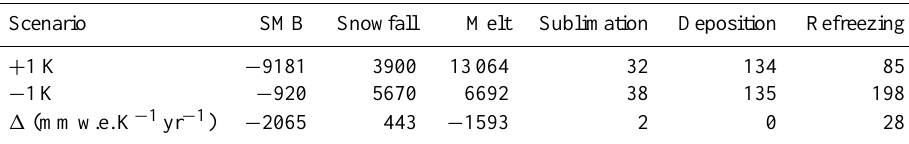
Table 8. Cumulative sum of SMB terms for selected runs of SEBpr over the 2-year sensitivity period. All units are in mmw.e., except for (cid:49) which is in mmw.e. K − 1 yr − 1 .